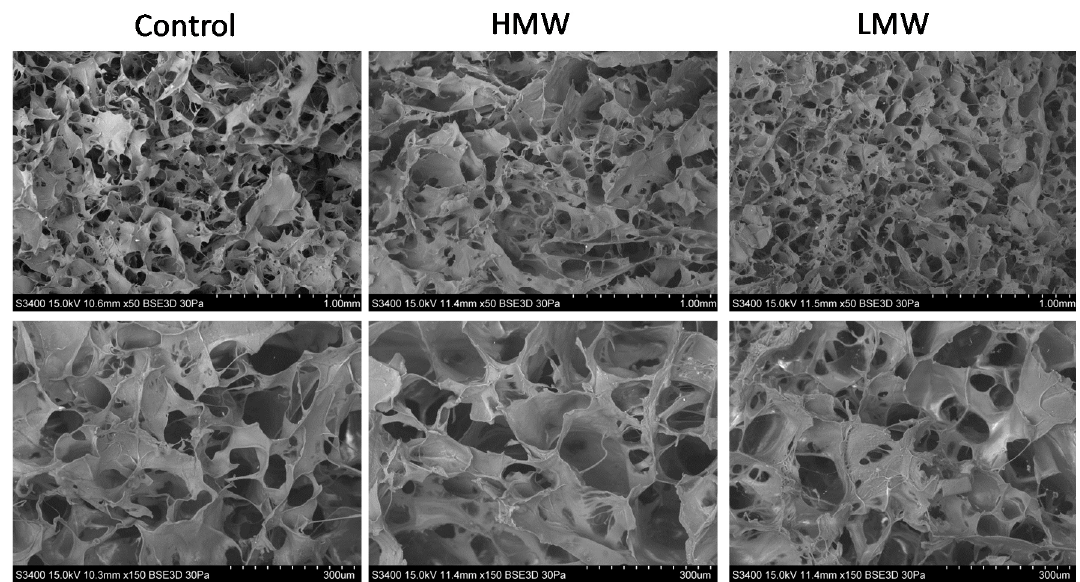
Figure 5. SEM images of control scaffolds and collagen scaffolds with HMW chitosan and LMW chitosan at a magnification of ×50 ( top ) and ×150 ( bottom ).